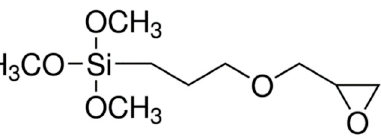
Figure 2. Chemical structure of 3-glycidoxypropyltrimethoxysilane (GLYMO).